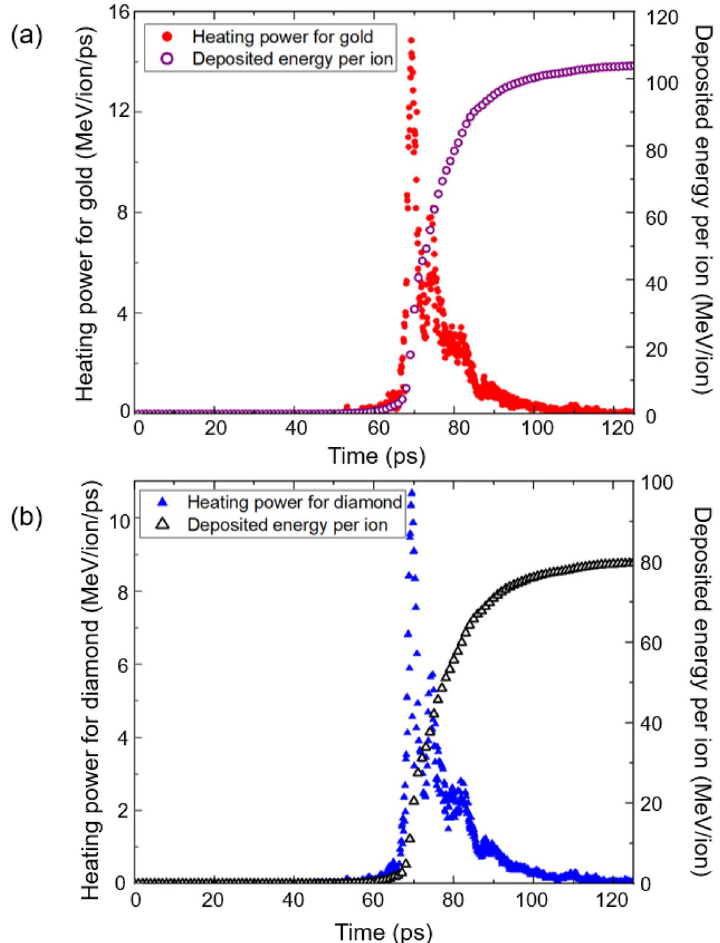
Figure 2. ( a ) The heating power of the incident aluminum ions for a 10-μm-thick gold sample at an angle of 45° is plotted as a function of time from 0 to 125 ps. The deposited energy per ion is also shown as a function of time. ( b ) The heating power for a 15-μm-thick diamond sample at an angle of 45° is shown as a function of time from 0–125 ps. The deposited energy per ion is also shown as a function of